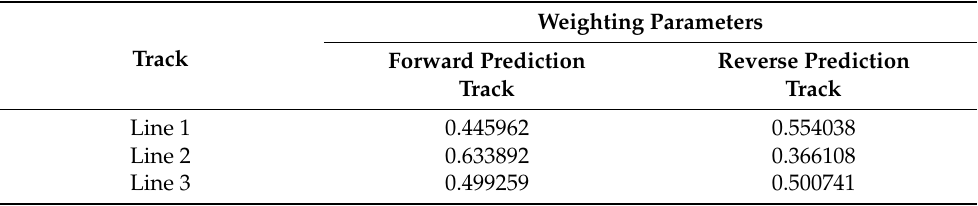
Table 1. Weighting parameters assigned by the entropy